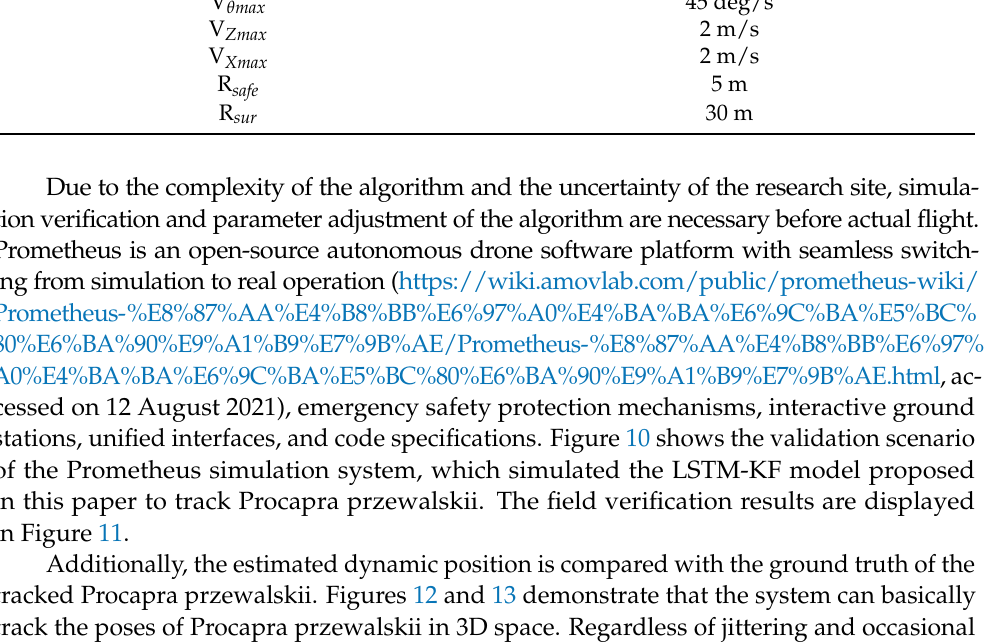
Table 3. De fi ned parameters for fl ight test.